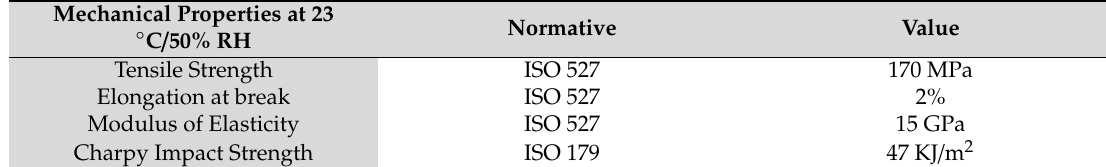
Table 1. Main mechanical properties of polyamide 12 reinforced with carbon microfibers (PA12-CR). Mechanical Properties at 23 ◦ C / 50% RH